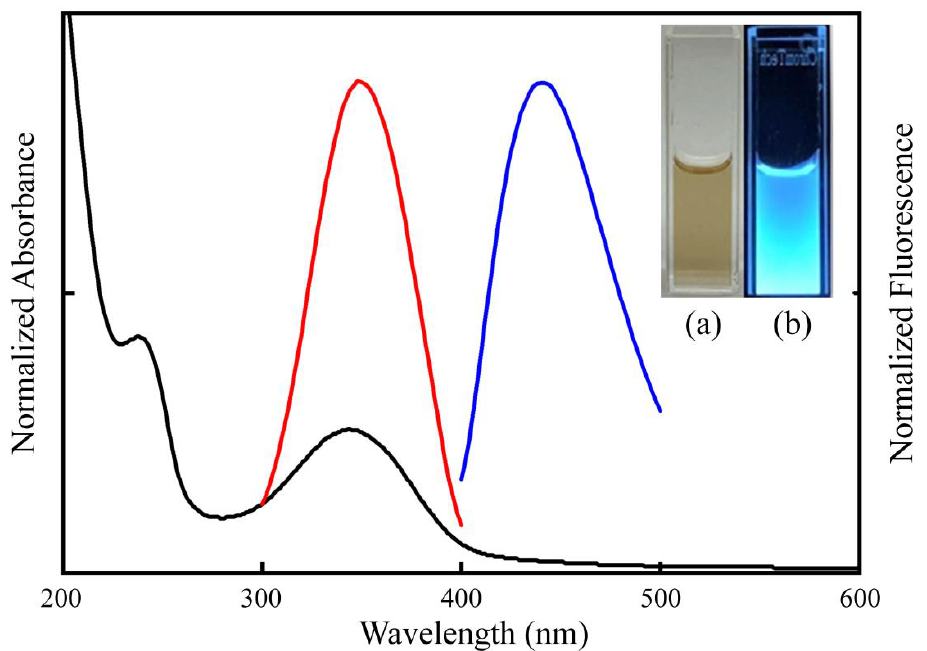
Figure 3. UV–vis absorption (black) and the maximum fluorescence excitation (red) and emission (blue) spectra of the NSCDs. Inset: Photos of the above suspension under ( a ) daylight and ( b ) UV irradiation (365 nm).